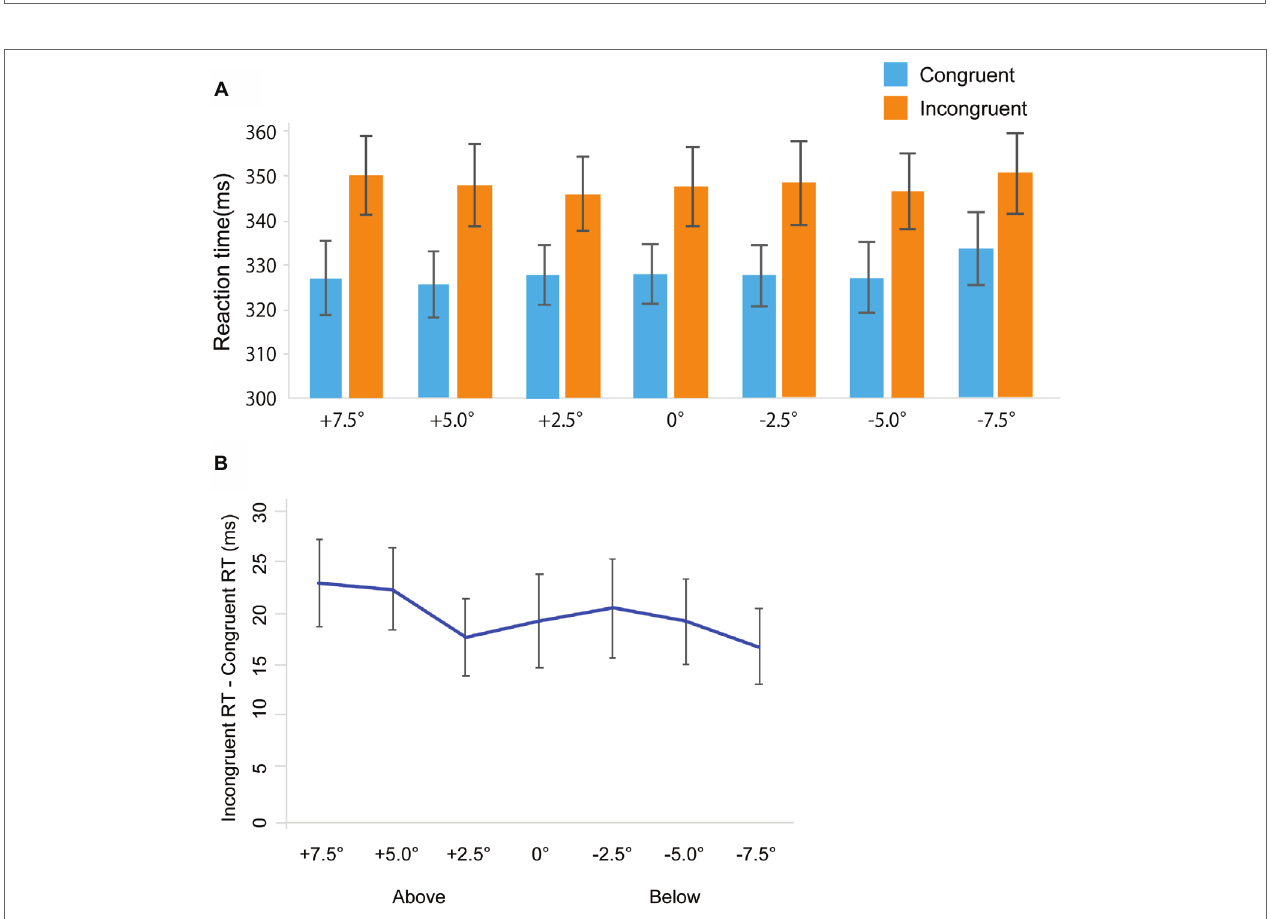
FIGURE 5 | Results in Experiment 3a. (A) Mean of (individual) median reaction time (ms). (B) The results of the magnitude of the gaze cuing effect (incongruent RT-congruent RT). The error bars represent standard error of mean.